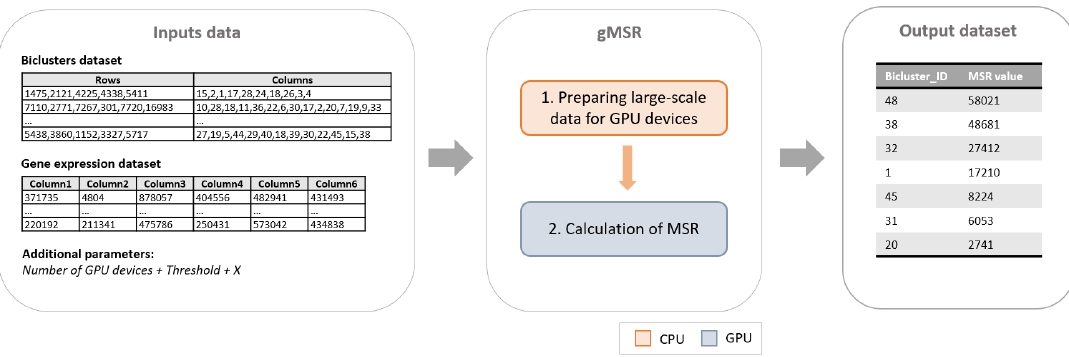
Figure 1. The general gMSR scheme is shown. As it can be observed, the input data is composed by the gene expression dataset, the set of biclusters extracted from it, the number of Graphic Processing Units (GPU) devices to use, the number of the best biclusters to be returned by gMSR, X, and the Mean Squared Residue (MSR) value threshold. Then, the gMSR algorithm is composed by two phases, the first one is executed in CPU, while the second one is executed in GPU. Finally, the output is a ranking of the X first biclusters based on their MSR